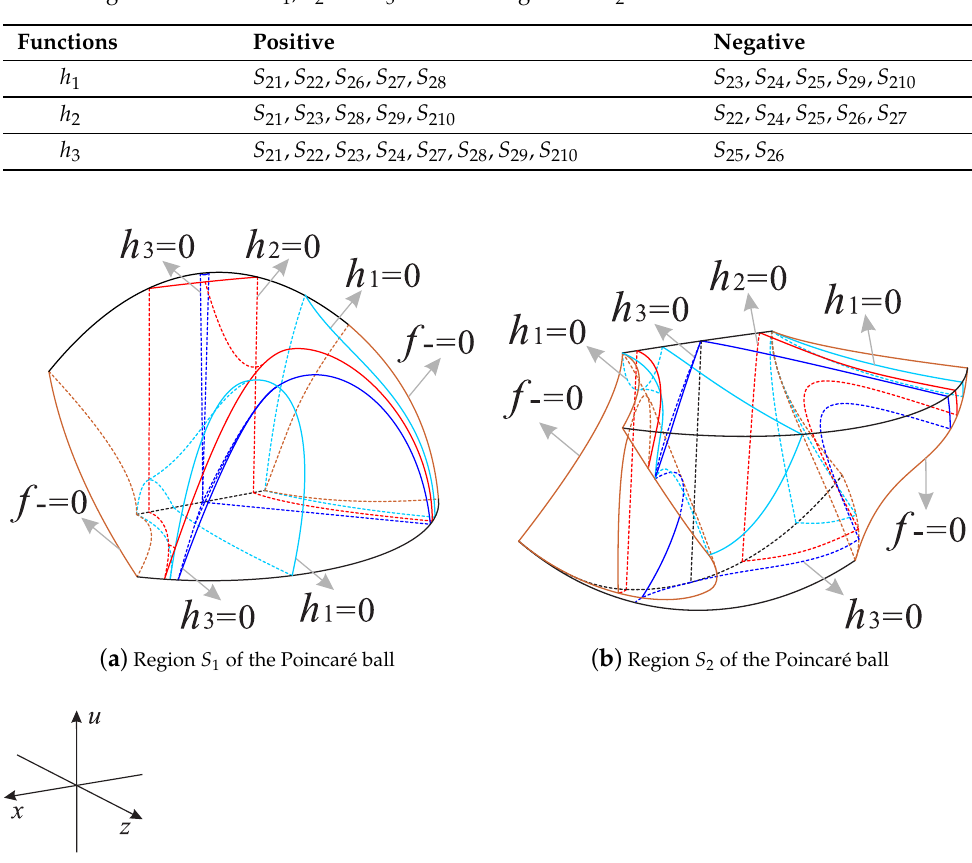
Figure 24. The surfaces h 1 , h 2 and h 3 restricted to the surface f − ( x , z , u ) = 0 and the regions S 1 and S 2 of the Poincaré ball,